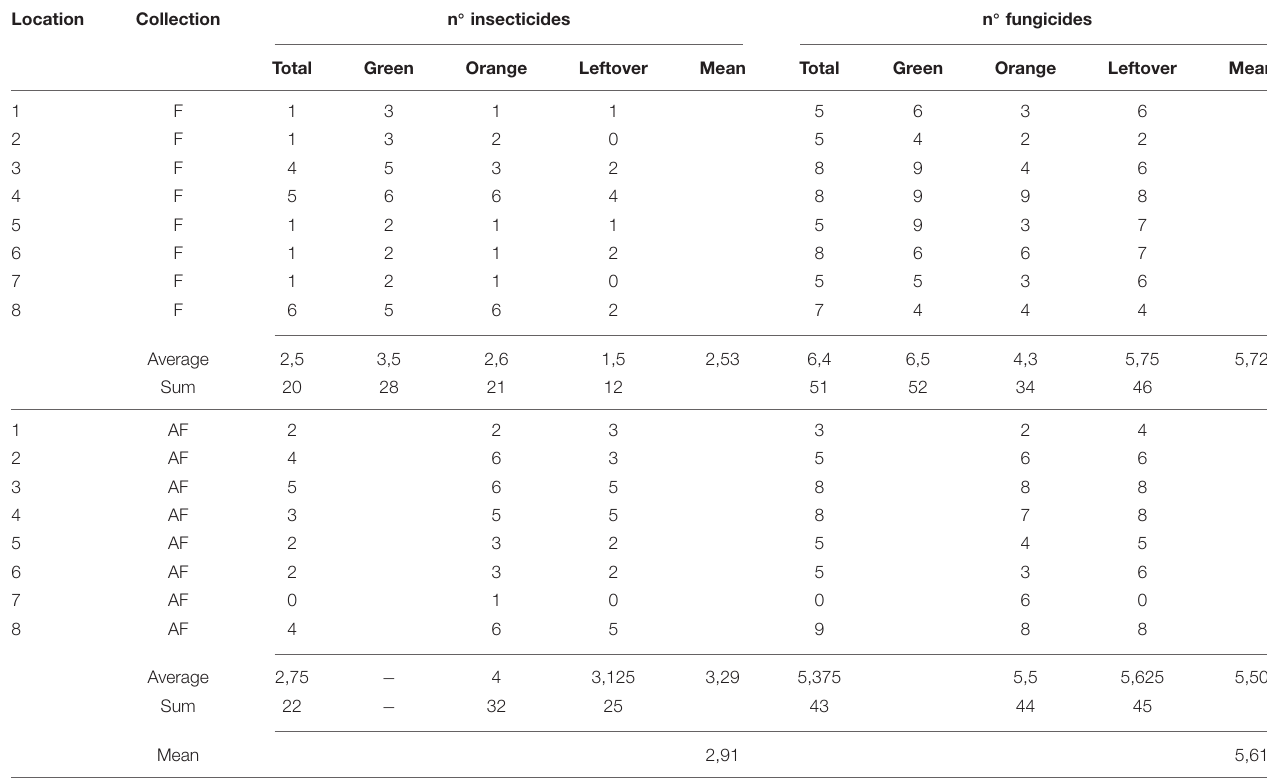
Values indicate the number of insecticide or fungicide residues found in pollen samples. The average of each color group is reported on the “average” row. The sum of the number of residues of each color group is reported on the “sum” row. The mean of the number of all the insecticide and fungicide residues is reported on the “mean” label. found at the maximum concentration of 0.2 ppm ( orange pollen) and 0.041 ppm ( total pollen),